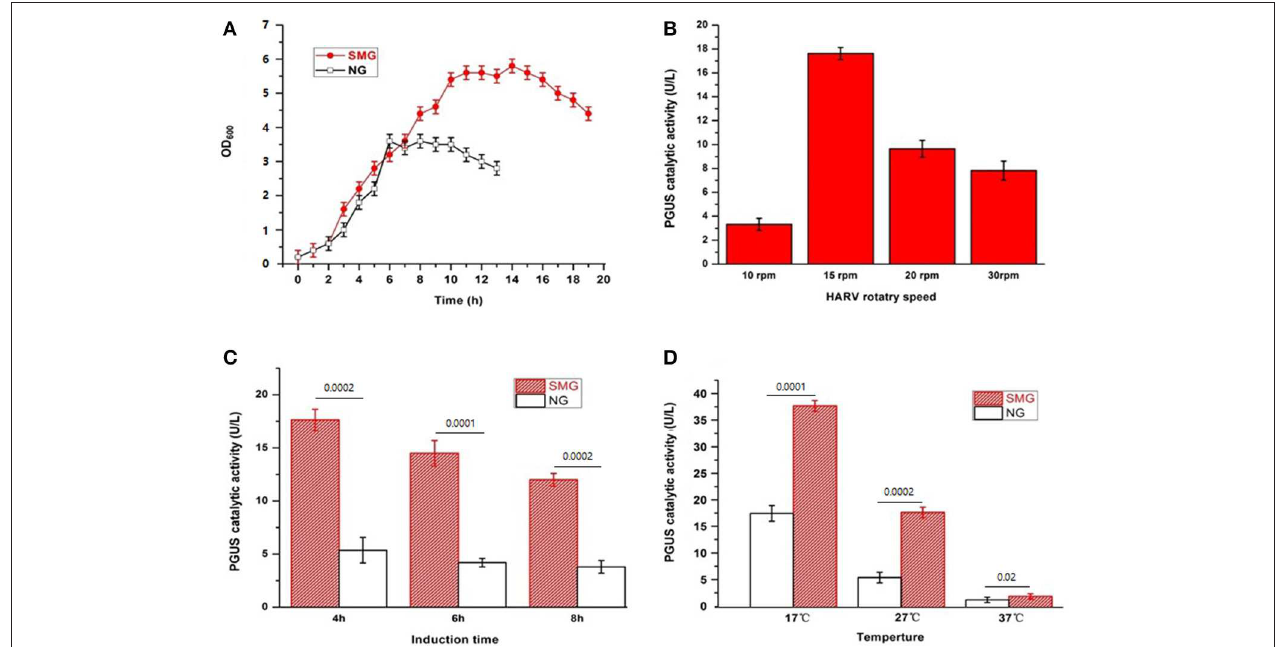
FIGURE 1 | The characteristics of the recombinant E. coli -pGUS under SMG and NG. (A) Growth curve of the strain at 37 ◦ C under SMG and NG at 15 rpm. Optimal HARV rotary speed (B) , induction time (C) , and induction temperature (D) for the recombinant pGUS expressed under SMG were determined. The default condition for the optimization of induction was 15 rpm, 4h, and 27 ◦ C. Significance was assessed using two-sided, paired Student’s t- test, and P -values are indicated as numbers in the graphs, n = 3.